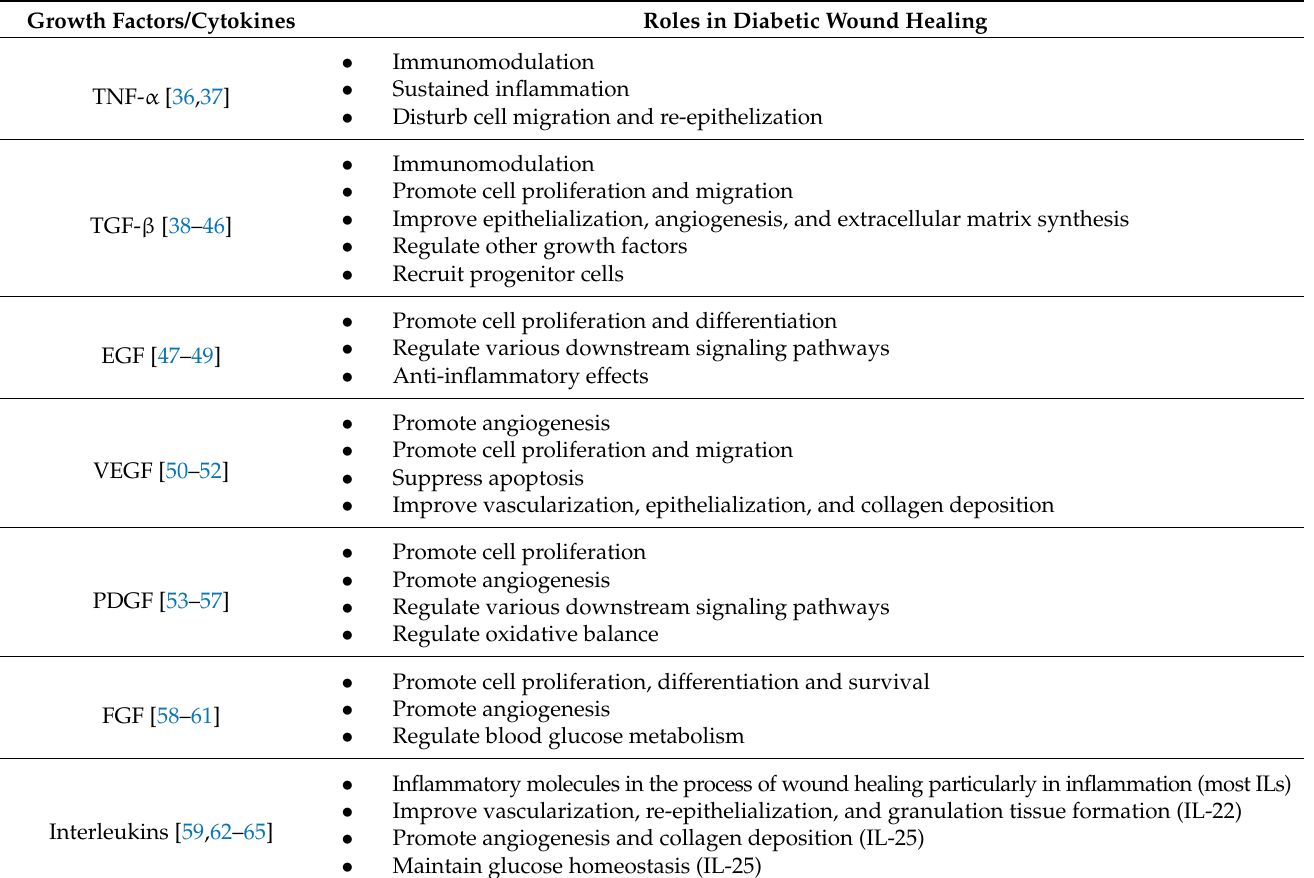
Table 1. The roles of major growth factors and cytokines in diabetic wound healing. (Numbers in the parentheses denote the reference